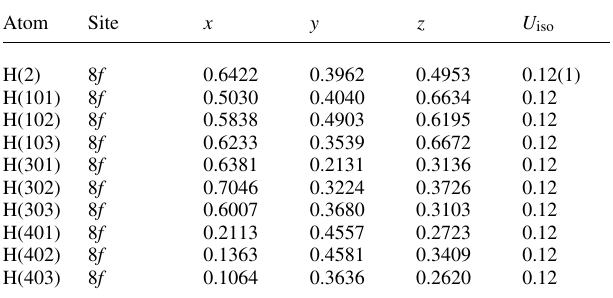
Table 2. Atomic coordinates and displacement parameters (in Å 2 ) .